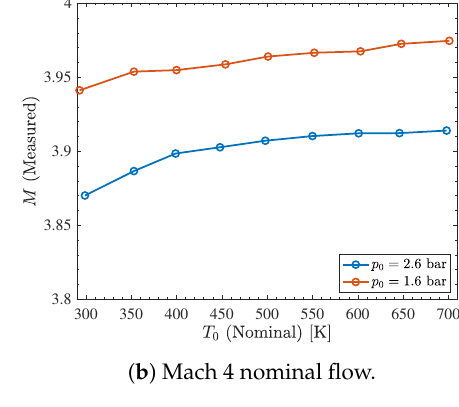
Figure 12. Average steady-state Mach number.